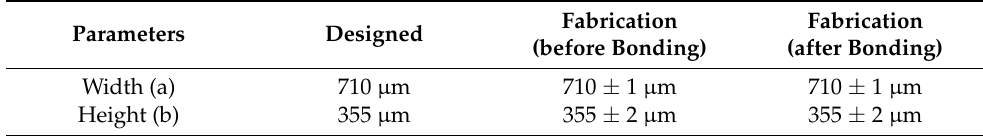
Table 5. Comparison between microfabricated and designed